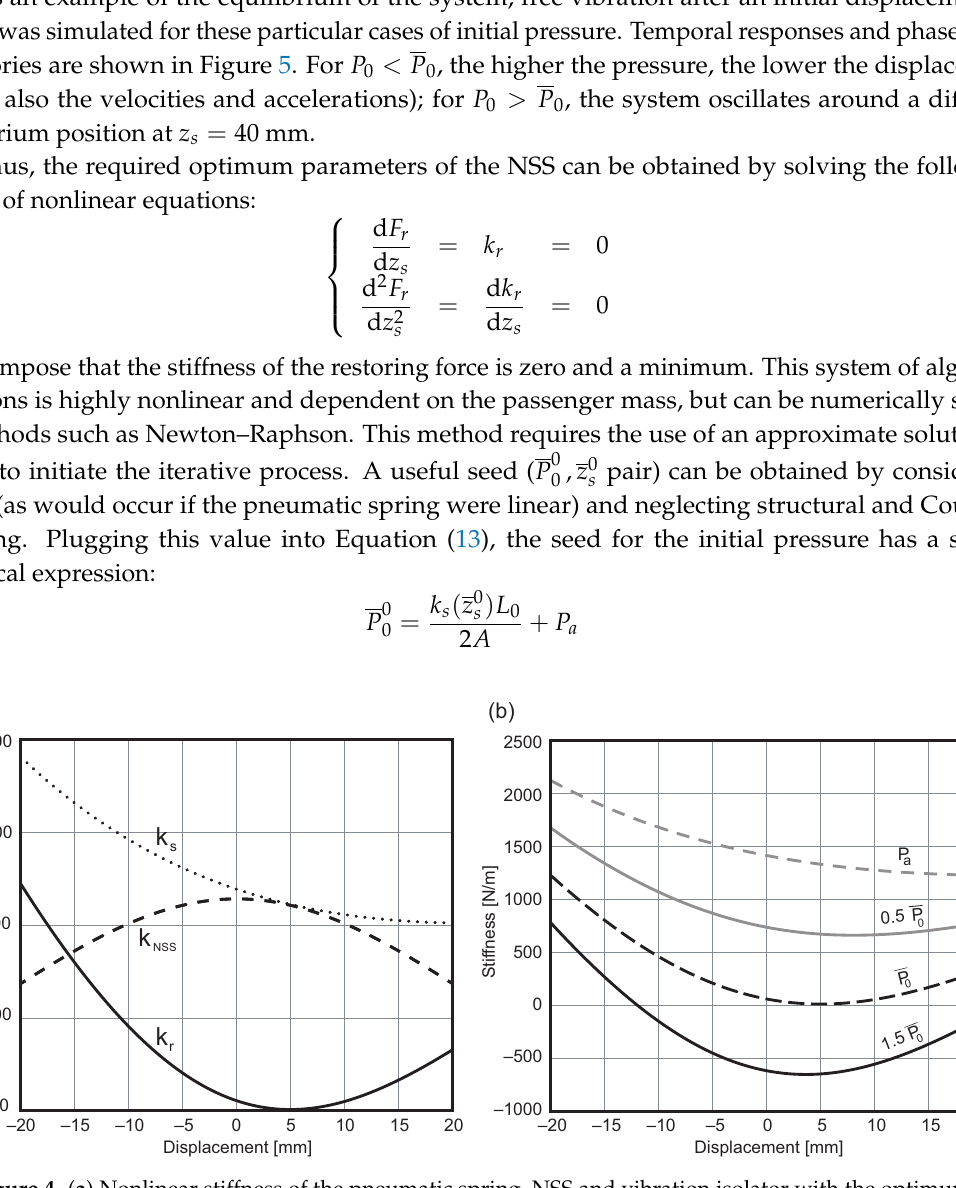
Figure 4. ( a ) Nonlinear stiffness of the pneumatic spring, NSS and vibration isolator with the optimum PLA pressure for a passenger mass of 75 kg; and ( b ) nonlinear stiffness of the vibration isolator for different initial PLA pressures for a passenger mass of 75